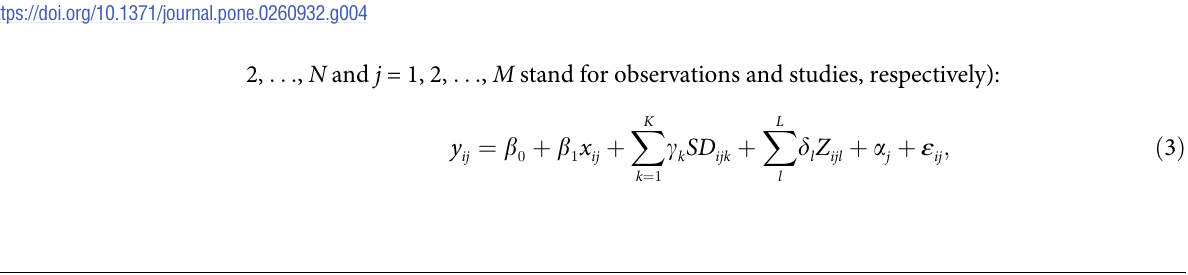
Fig 4. Forest plot of external social